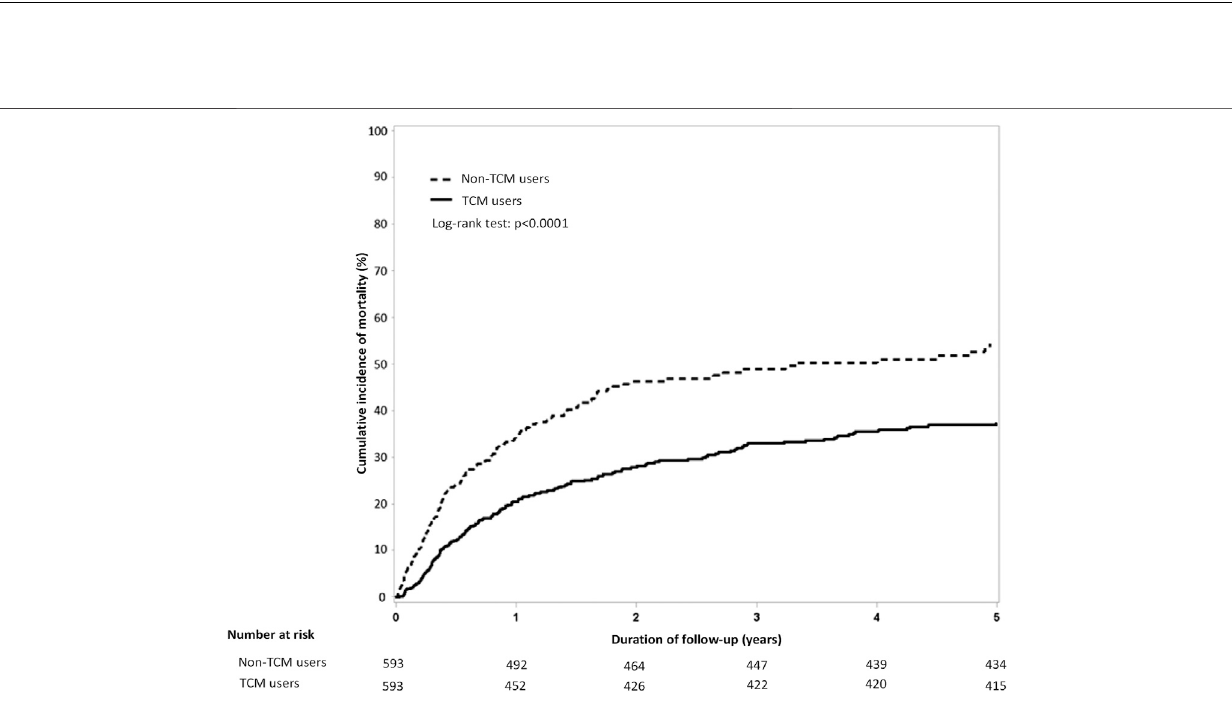
Frontiers in Pharmacology |